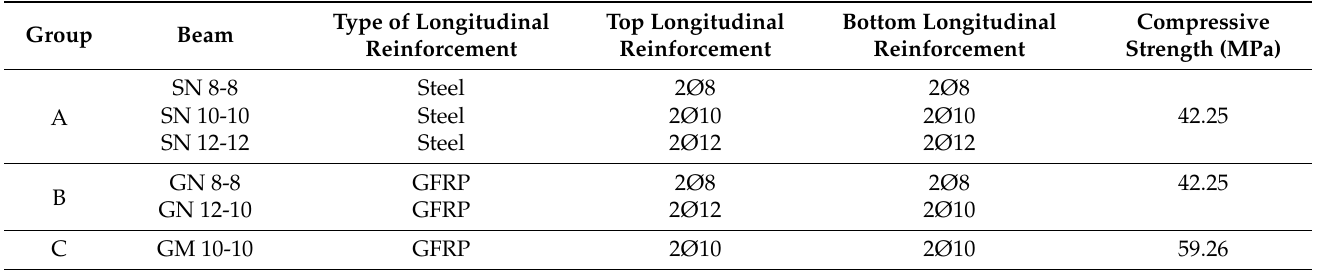
Table 3. Compressive strength of concrete and reinforcement